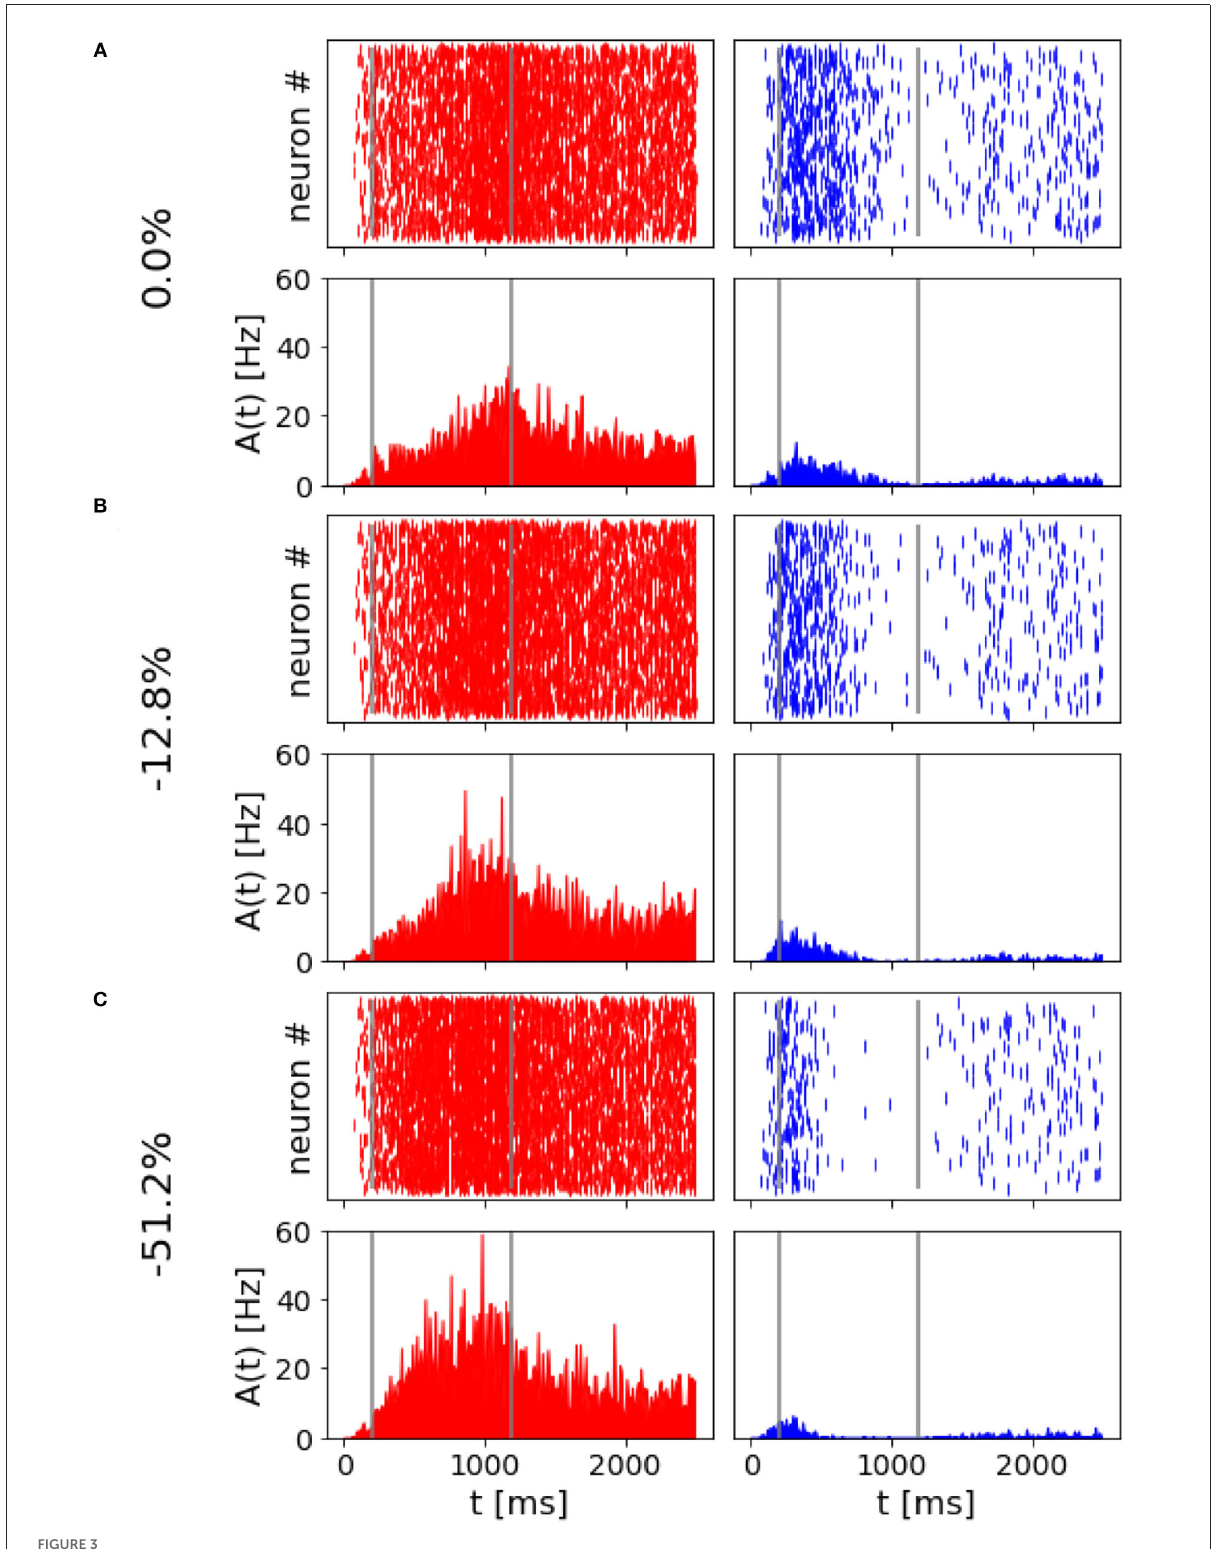
FIGURE3 Network activity at different coherence levels: Population A response is reported on the left panels, population B response on the right. In (A–C) , top panels report the raster plot for the spiking activity for all neurons, while the bottom plots report frequency rates of the two populations. Gray vertical lines indicate the start and end of the stimulus delivery. (A) Simulation output for a trial where 0.0% coherence level was provided and population A wins. (B) Trial with 12.8% of stimulus coherence. (C) Trial with 51.2% of stimulus